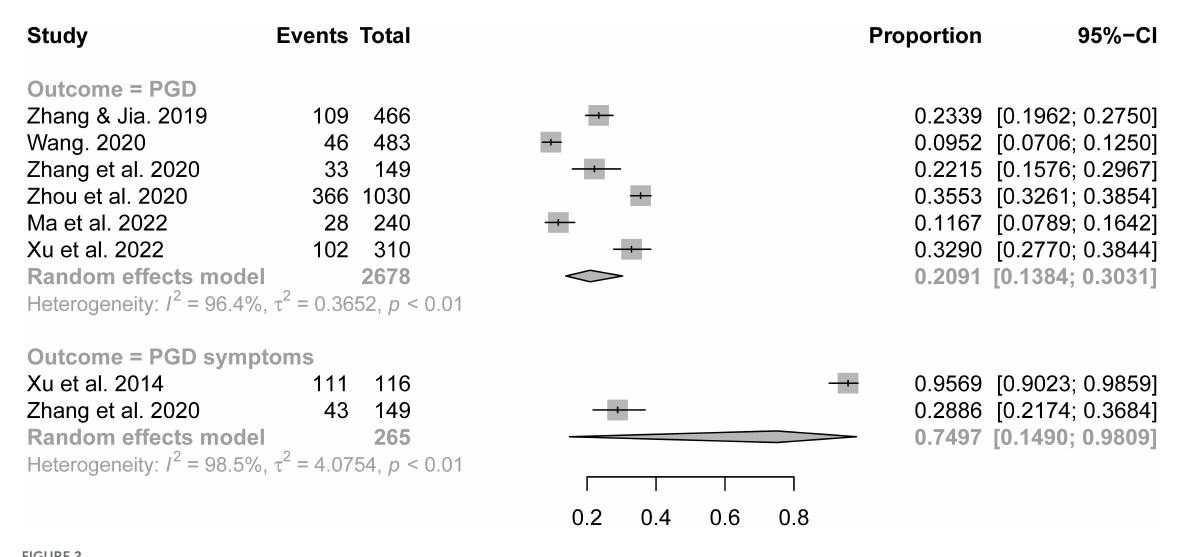
FIGURE2 Forest plot of prevalence of prolonged grief disorder and its